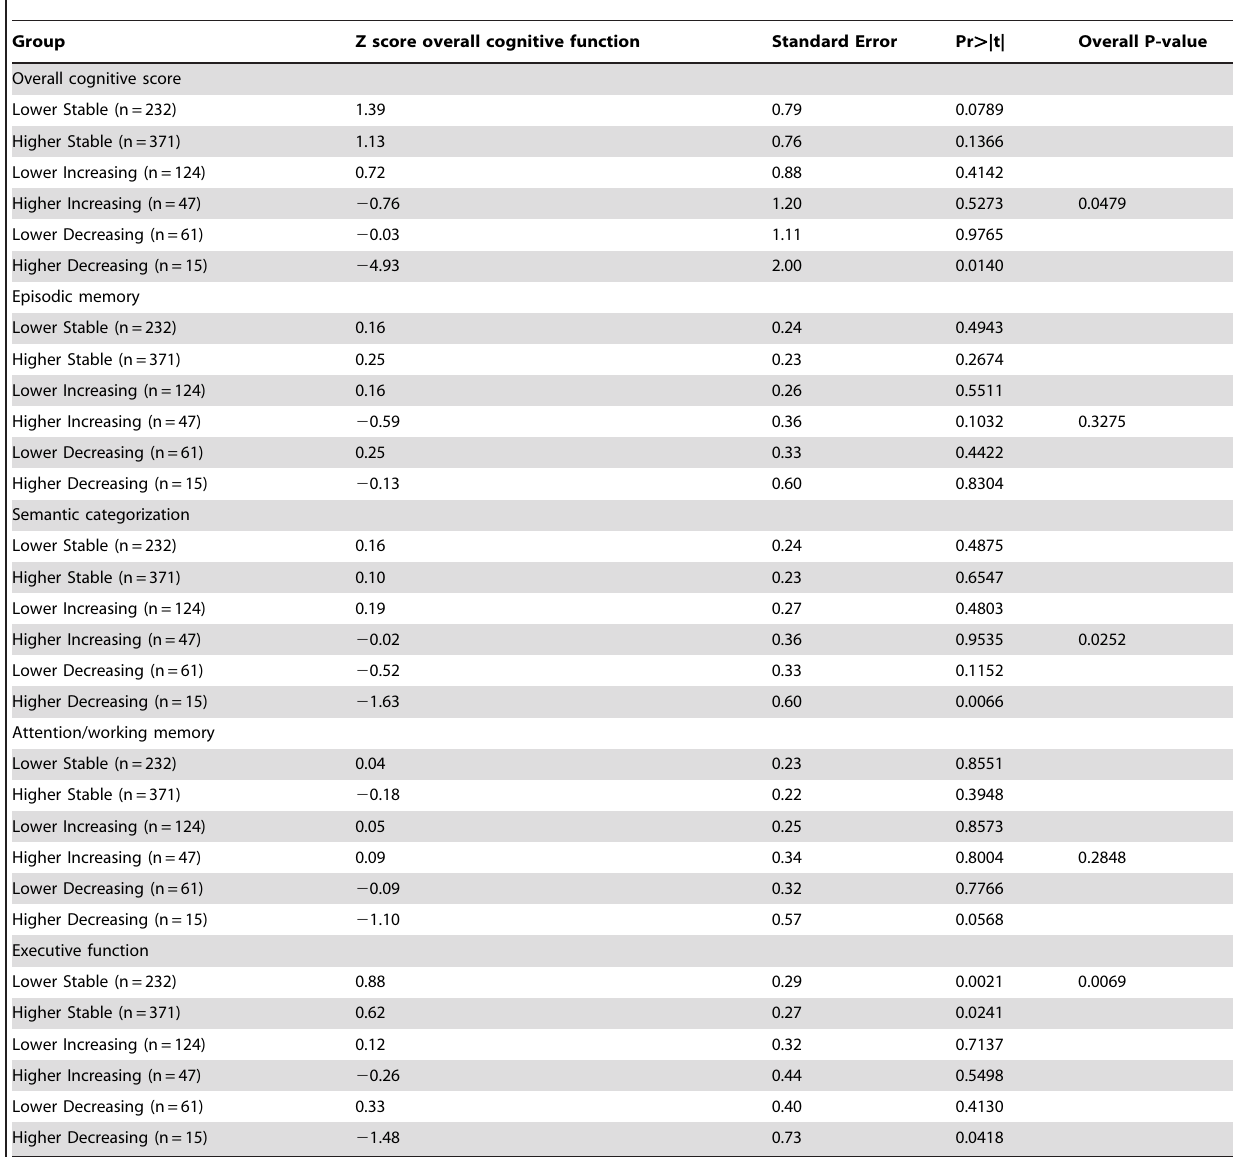
Table 2. Cognitive scores (Z scores) in groups of subjects defined by HbA1c at entry into the Diabetes Registry and trend over time in the